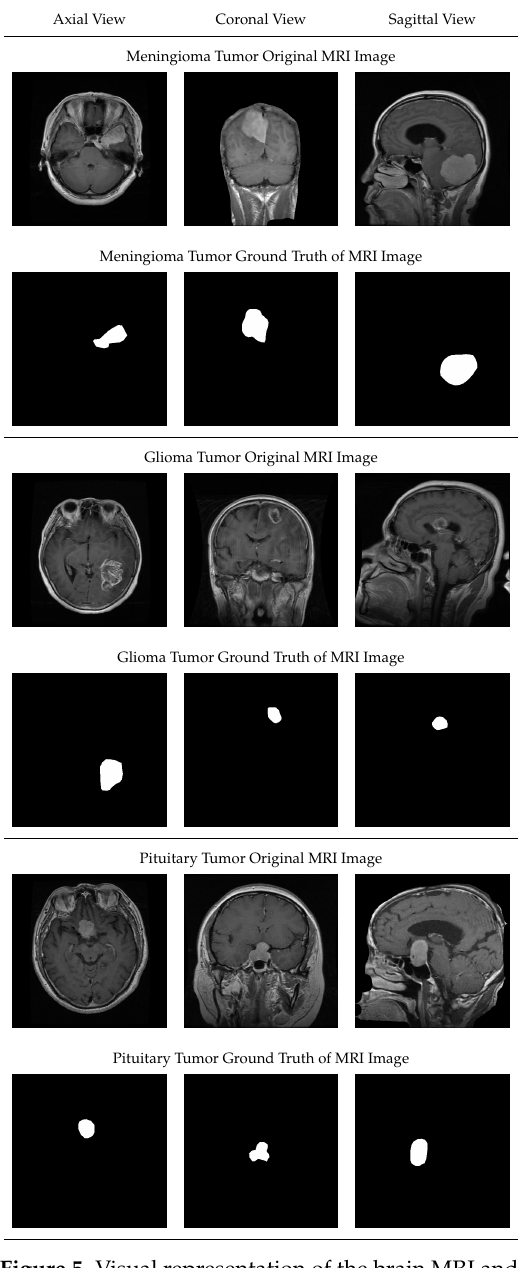
Figure 5. Visual representation of the brain MRI and respective ground truth